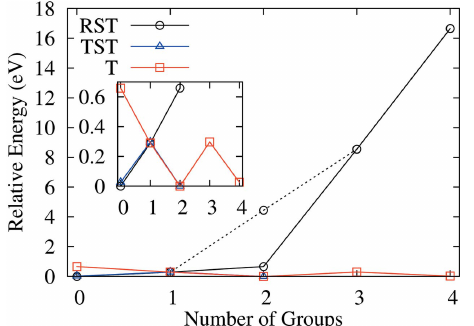
(cid:3) 32.002 Figure 15